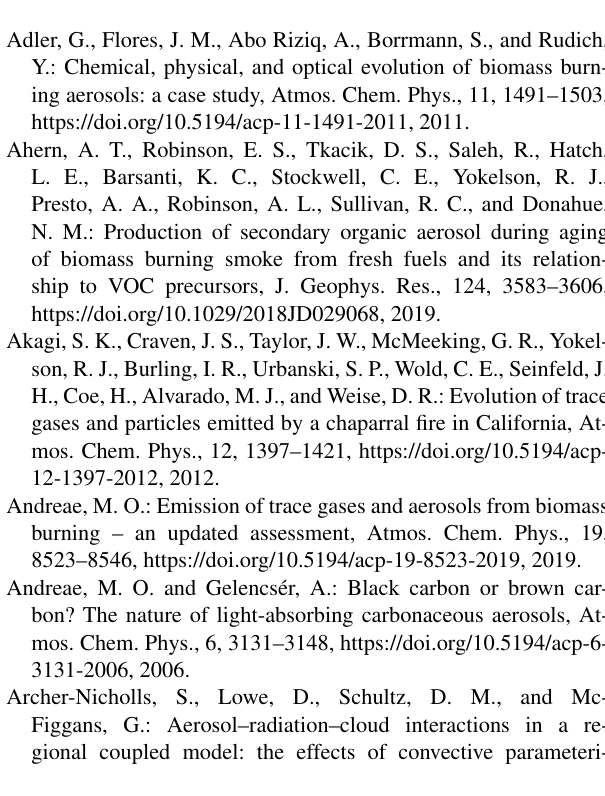
Figgans, G.: Aerosol–radiation–cloud interactions in a re- gional coupled model: the effects of convective